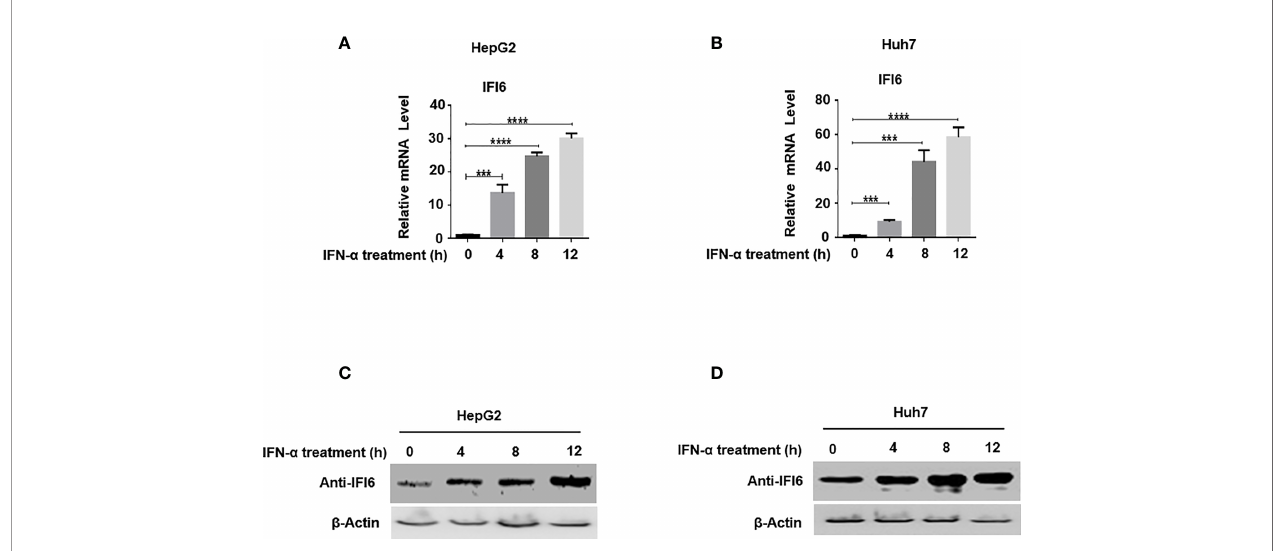
FIGURE 1 | Expression level of IFI6 is signi fi cantly induced by IFN- a in Hepatocytes. HepG2 and Huh7 cells were seeded in 12 well cell culture plates. After 24 hours, cells were treated with human IFN- a (100 ng/ml). Samples were collected at 0, 4, 8, and 12 hours after IFN- a treatment and total RNA was puri fi ed and subjected to qRT-PCR (A, B) and western blot for protein detection (C, D). The anti-IFI6 antibody was used to determine the protein level of IF6. Expression of b -actin was used as a loading control. The data are averages of three independent experiments; the results were measured as a mean ± SD and statistically analyzed. *** P < 0.001, **** P <